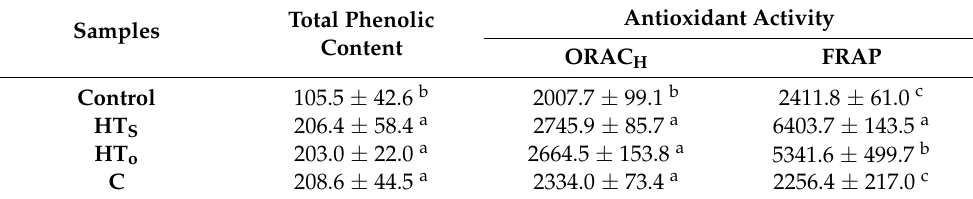
Figure 3. Sensory analysis ( A ) and acceptability ( B ) of fuet samples. HT s , samples enriched with synthetic Hydroxytyrosol; HT o , samples enriched with organic Hydroxytyrosol; C, samples enriched with citric. a, b Indicates significant differences among samples ( p < 0.05). Table 7. Total phenolic content (mg GAE kg − 1 ) and antioxidant activity ( µ mol TE kg − 1 ) of fuet